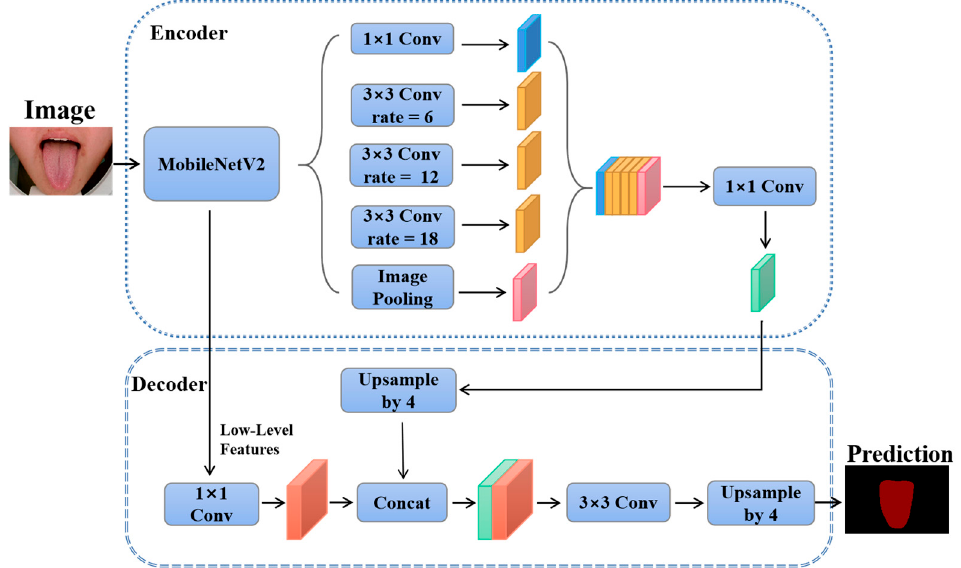
Figure 3. Structure of Deeplabv3+. The high-level semantic features and the low-level semantic features of the tongue image are extracted and fused by the Deeplabv3+ network. The low-level features have high resolution and contain a wealth of detailed information about the image. The high-level features have stronger semantic information. The fusion of features of different scales is an important method to improve the performance of segmentation networks.